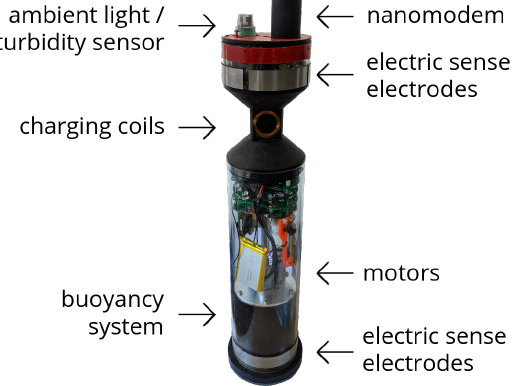
Figure 2. The aMussel underwater robot and sensor node. Note in particular the inductive charging coils on the narrow neck below the top cap segment